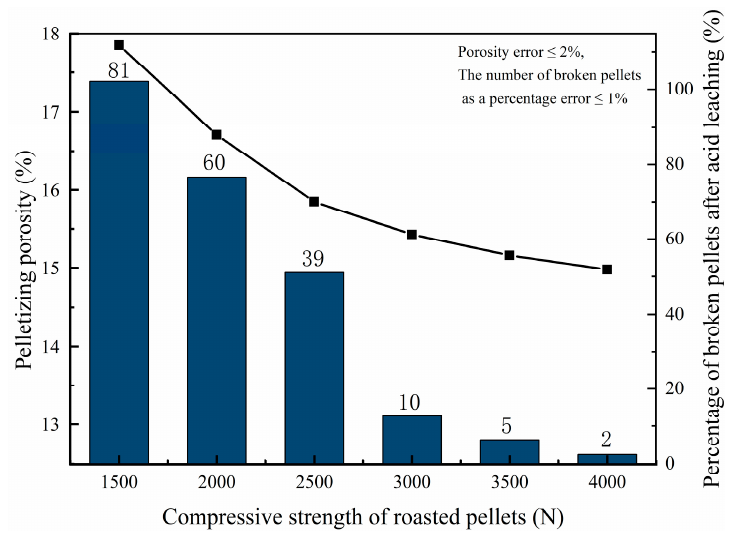
Figure 10. Effect of compressive strength of calcined pellets on properties of acid-leached pellets.